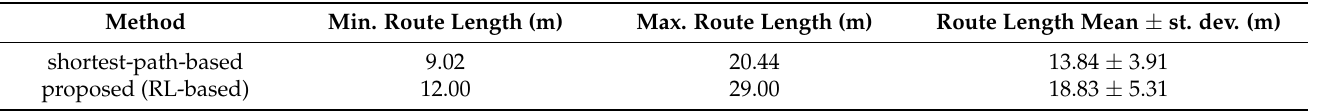
Figure 9. Routes generated by the trained RL agent. The coloured squares (blue, red, green, and yellow) indicate pick- up/drop-off locations, and the colour of the route indicates to which pick-up location the route belongs. All four locations (blue, red, green, and yellow squares) represent both pick-up as well as drop-off locations (robots may travel in both directions for any pair of these locations). When the robot needs to travel from a pick-up location to a drop-off location, it follows a route that is the same colour as the pick-up location. Table 5. Routes lengths, shortest path-based, and proposed